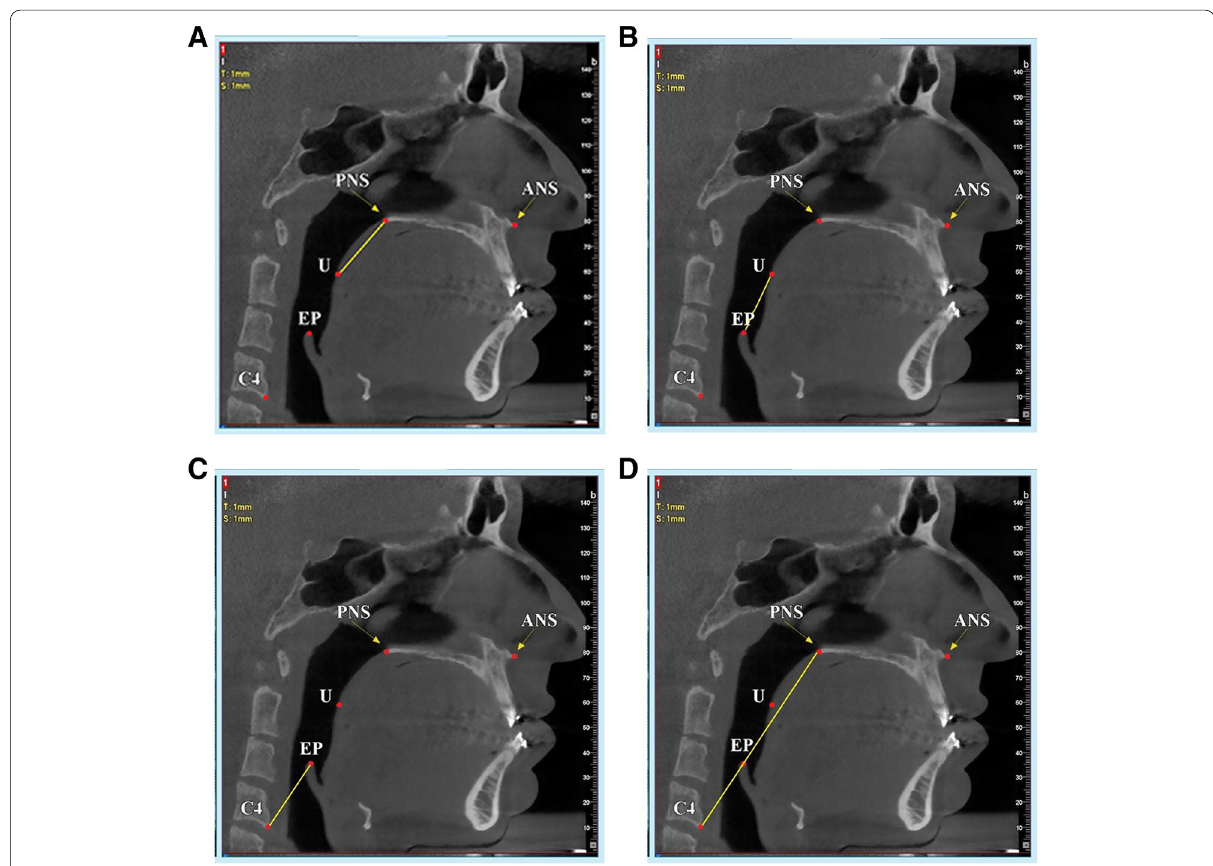
Fig. 2 A The distance between the posterior nasal spine (PNS) and the uvula (U) was considered the representative of the velopharynx segment. B The distance between the uvula and the epiglottis (E) was considered the representative of the oropharynx segment. C The distance between the epiglottis and the most anterior point of the fourth cervical vertebra (C4) was considered the representative of the hypopharynx segment. D The distance between the PNS and C4 was considered the representative of the total pharyngeal airway